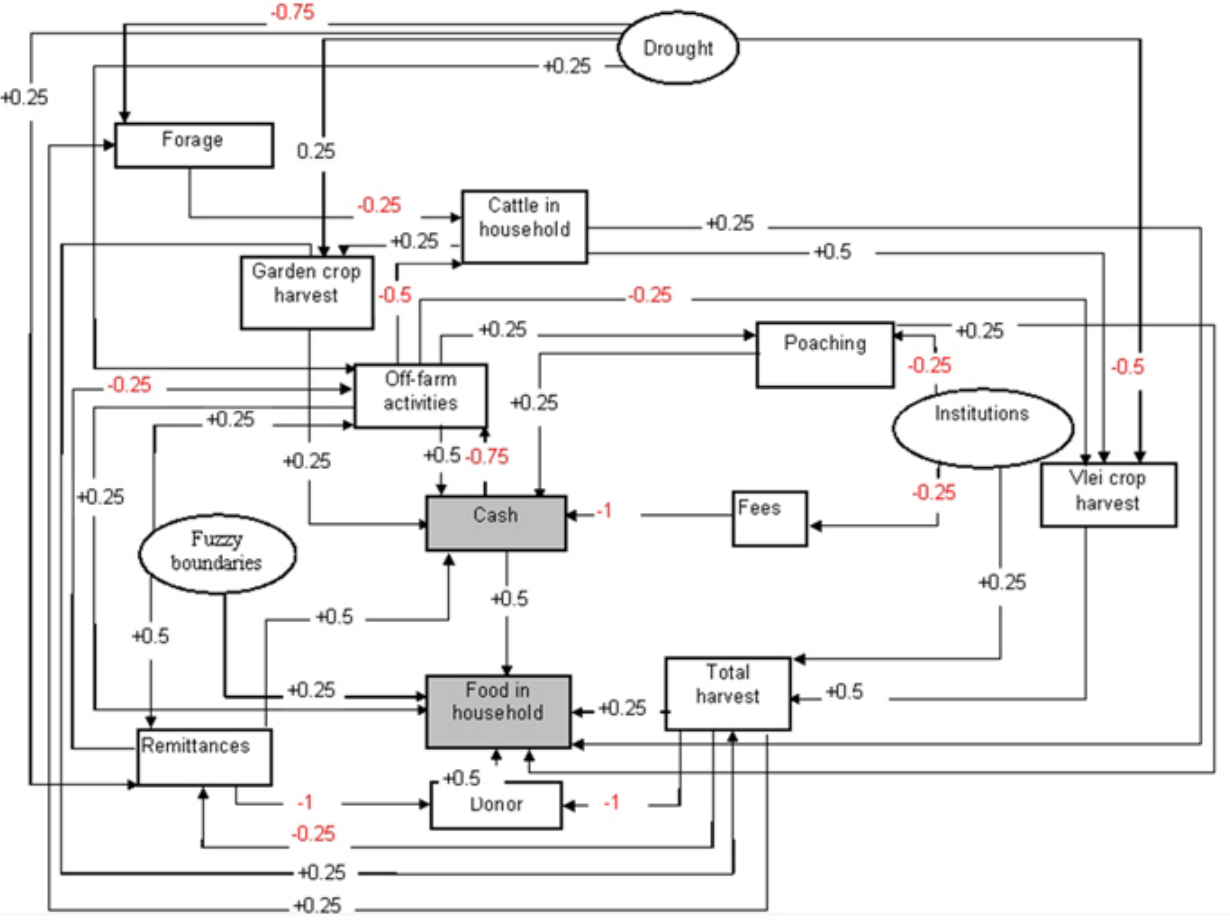
Fig. 6. Fuzzy cognitive map of the non-farm-based livelihood type. Grey boxes are key indicators of the functioning of the livelihood; white boxes are variables; white circles are system drivers. Numbers given are influences between factors, where red font indicates negative relationships, and black font indicates positive